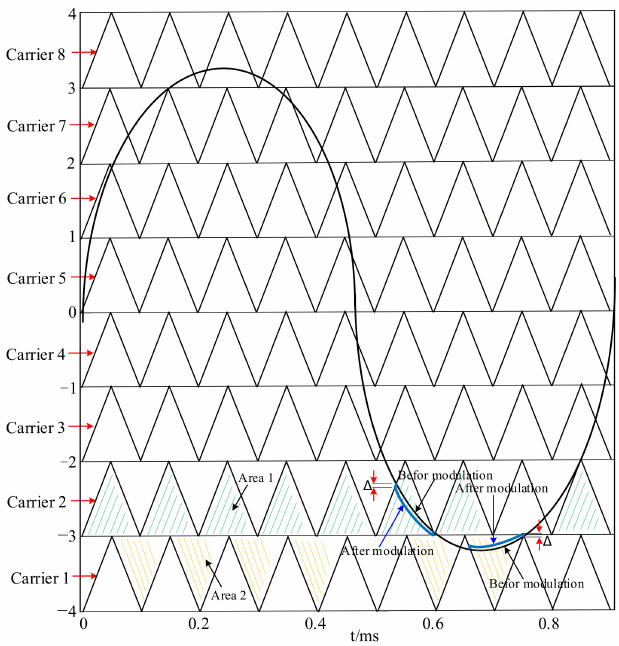
Figure 11. Schematic diagram of unit capacitor voltage